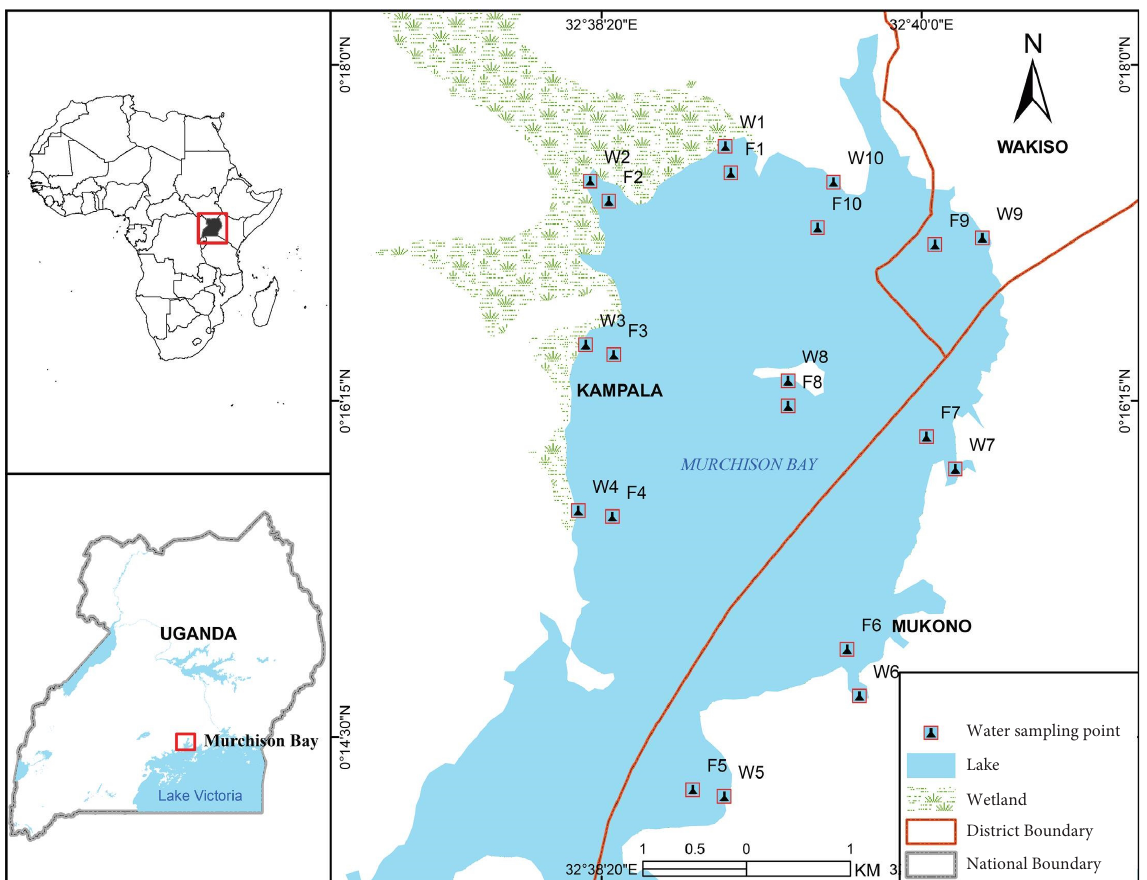
Figure 1: Water sampling locations in the Murchison Bay, Lake Victoria (W1 ∼ W10 � water hyacinth-infested sampling areas while F1 ∼ F10 � open lake environment sampling